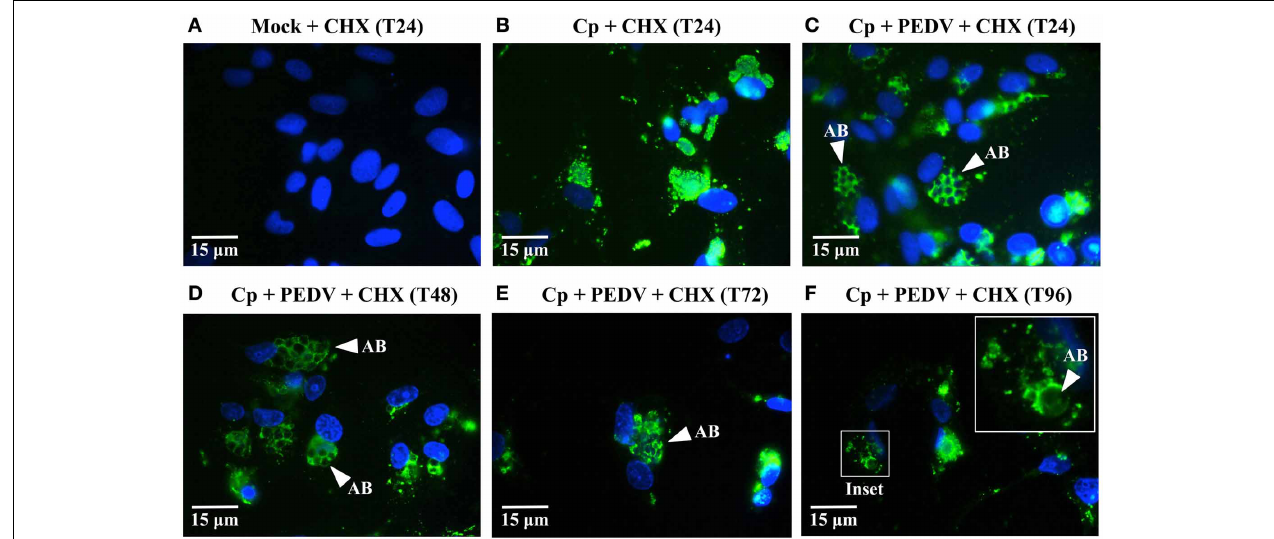
FIGURE 3 | ABs are present in co-infected cells for up to 96 hpvi when PEDV replication is blocked. (A–F) Vero cells were mock-infected (Mock), mono-infected with C. pecorum (Cp), or co-infected with C. pecorum and PEDV (Cp + PEDV) as diagrammed in Figure 1A . All cultures were pre-exposed to 5 μ g/ml CHX starting at 1h before viral infection to prevent PEDV replication, as indicated. At 24 hpvi (T24), 48 hpvi (T48), 72 hpvi (T72), and 96 hpvi (T96), replicate coverslips were fixed and labeled with